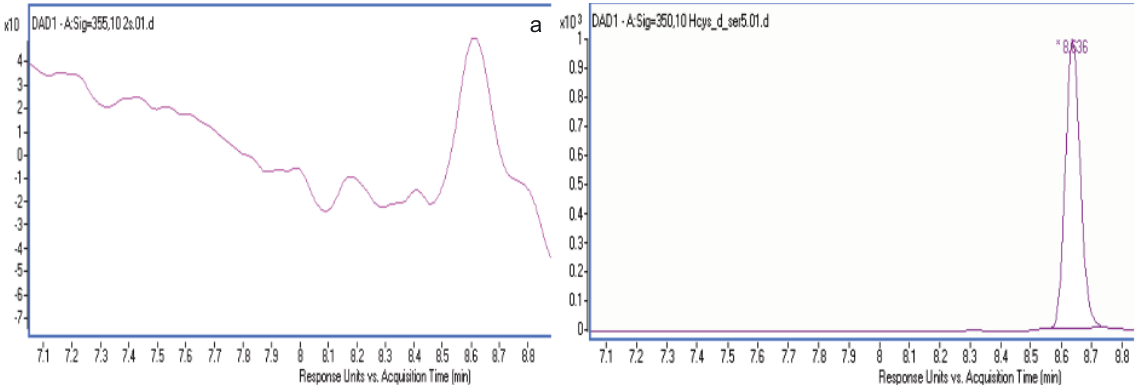
Figure 1. Chromatograms of plasma samples obtained from the same rat, initially (a) and after methionine administration